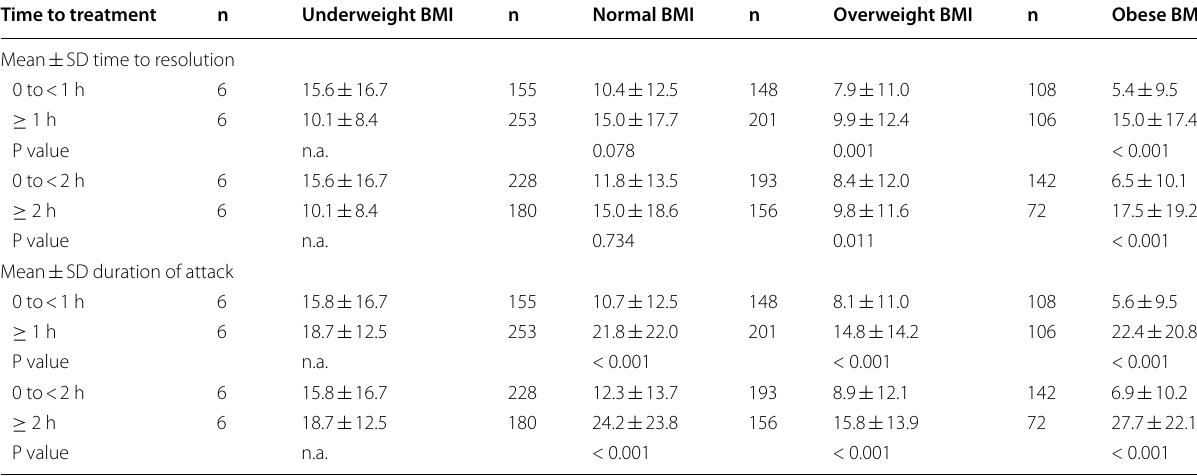
Table 4 Impact of time to treatment on mean time to resolution and duration of attack